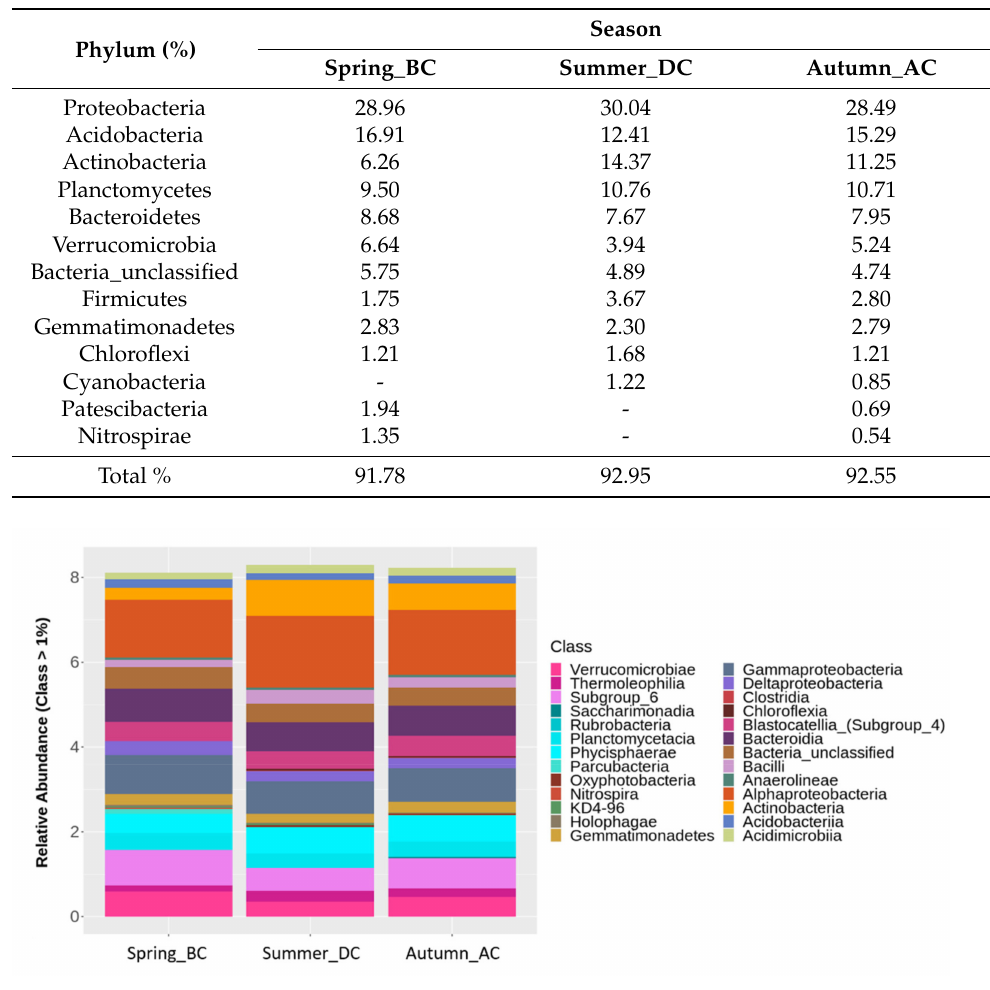
Figure 4. Classification of bacterial classes based on relative abundance at rate greater than 1% over three seasons: Spring_before cultivation (BC), Summer_during cultivation (DC), Autumn_after cultivation (AC) of the runner bean crop across the soil samples of nine field sites. The different classes are depicted in different